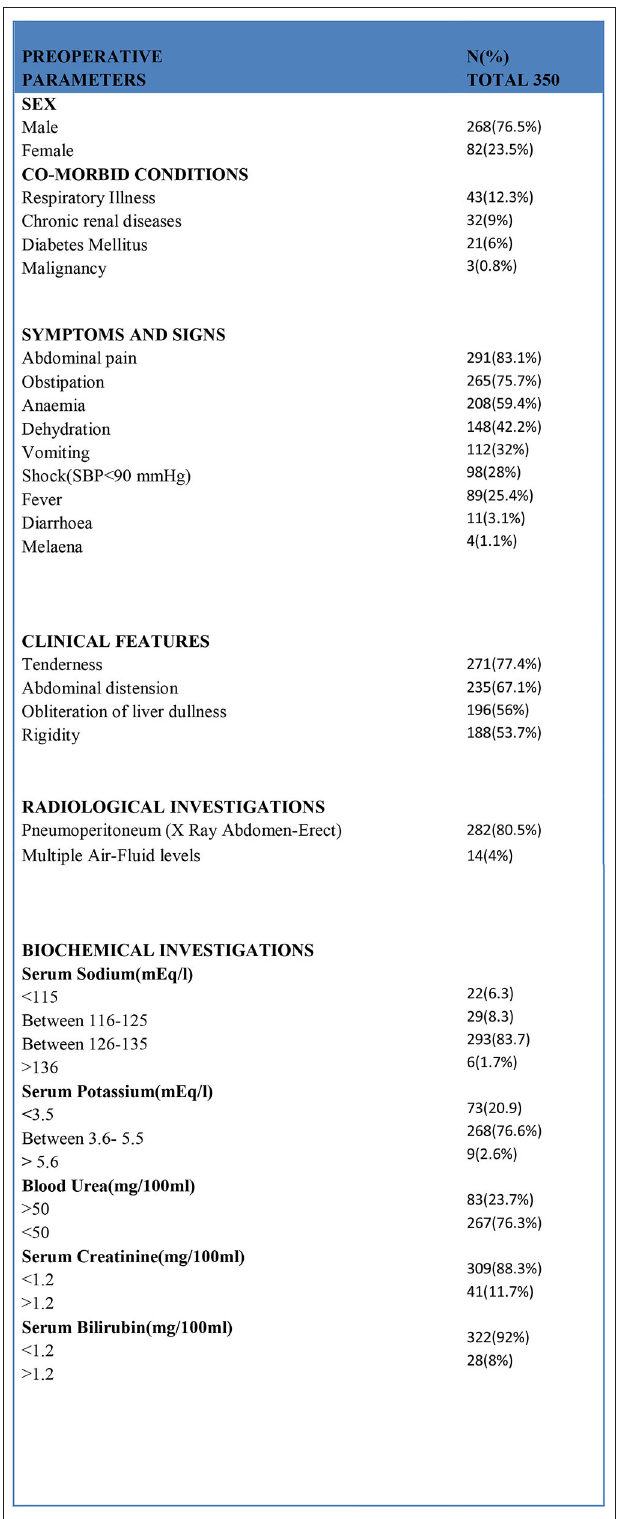
FIGURE 3 | Various preoperative